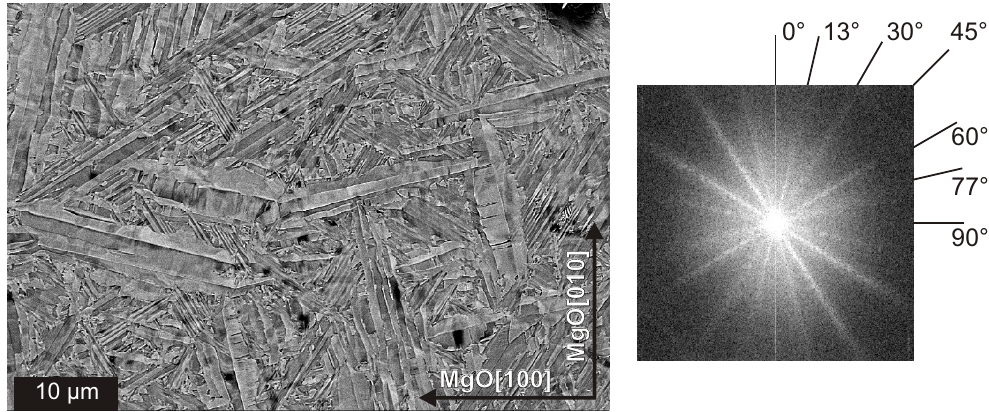
Figure 8. SEM picture (Backscatterd electron contrast) of a twinned microstructure obtained for an annealed Fe Pd film. The edges of the picture are parallel to MgO (cid:104) 100 (cid:105) . The 75 25 inset shows the corresponding FFT and two different angles are visible ( 13 ◦ and 30 ◦ ), which originate from two different twin